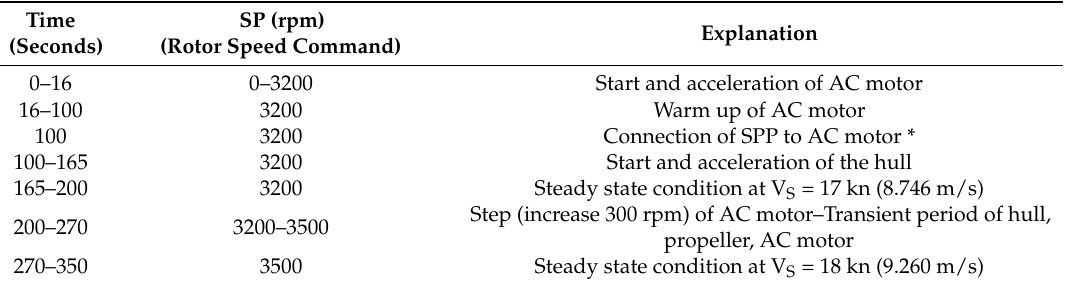
Table 8. Simulation run schedule and description.